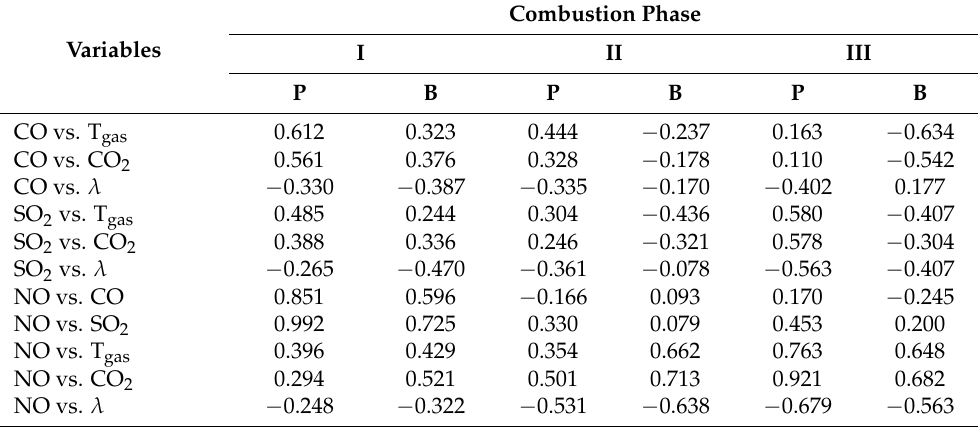
Table 4. Pearson correlation coefficient for the relationship between combustion products and parameters describing the course of the combustion